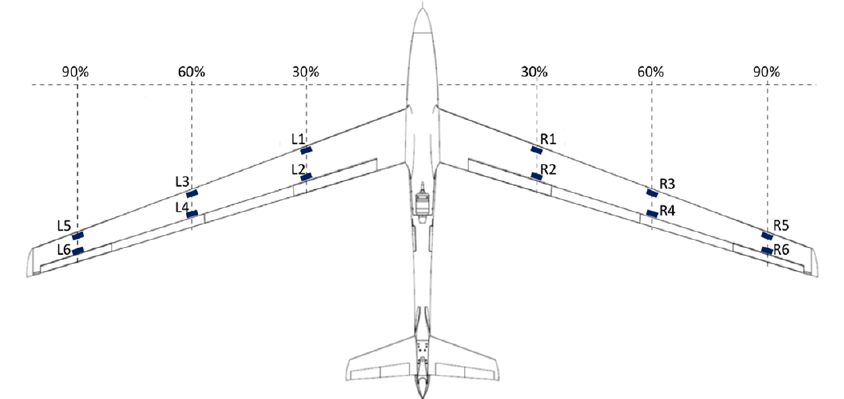
Figure 5. Locations of the IMUs installed in the wings to measure the accelerations on the